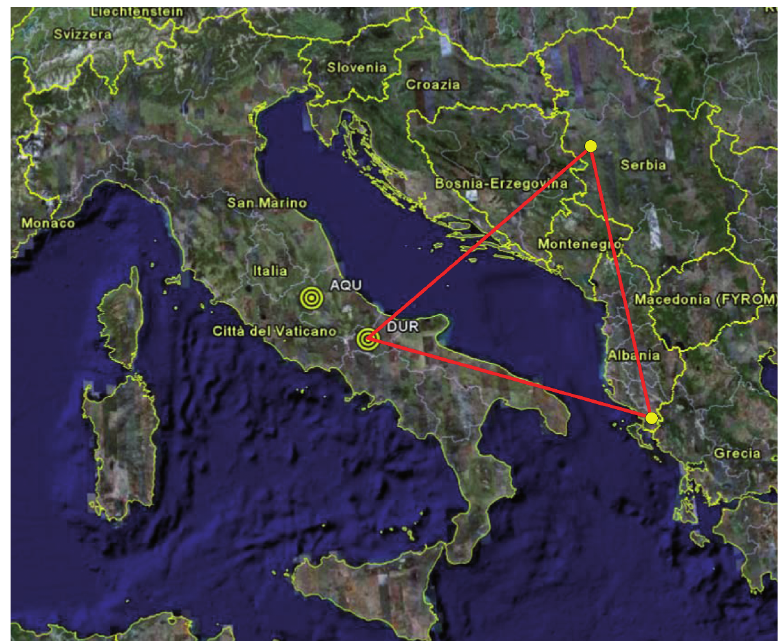
Fig. 1. Location in Central Italy of the first two MEM stations of L’Aquila (AQU) and Duronia (DUR). The red triangle shows the pattern of the planned interferometer in the Adriatic